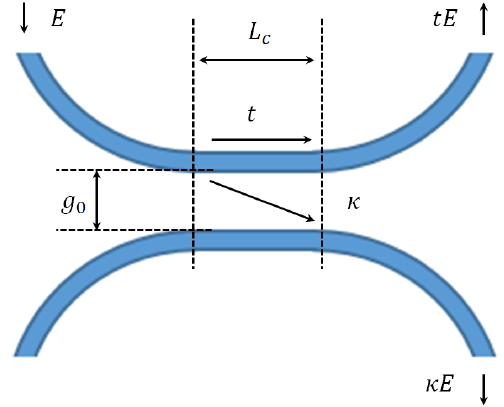
Figure 3. The parametrical model of the directional